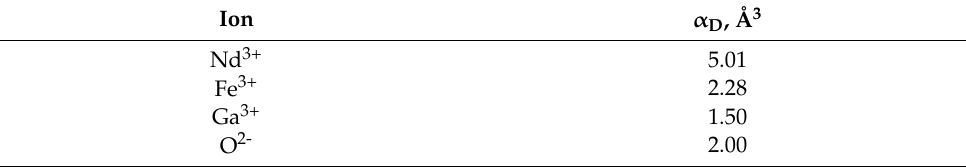
Table 4. The polarizabilities of ions